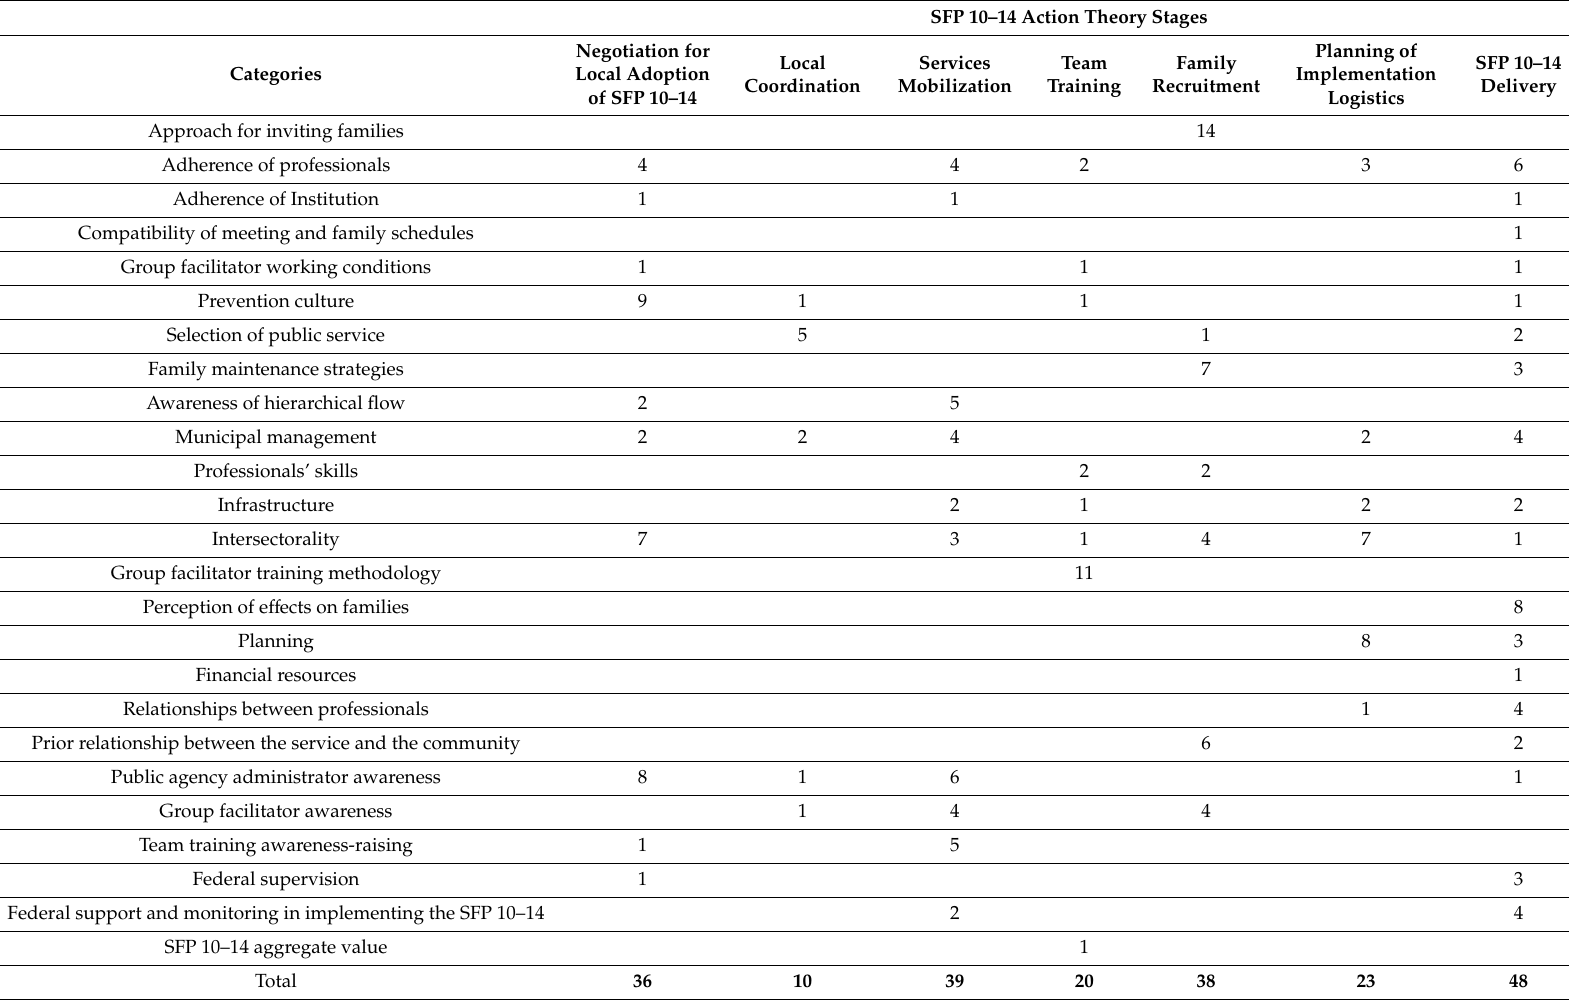
Table 4. Frequency of topics identified as facilitators of the SFP 10–14 implementation process by the action theory stage in